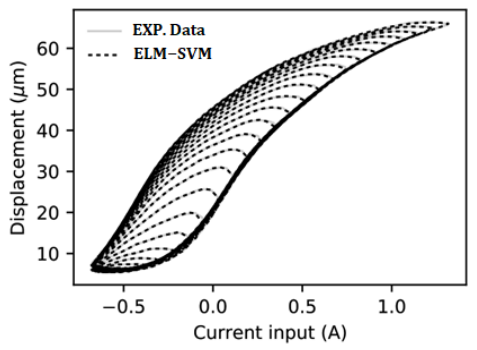
Figure 10. The measured output displacement against the input current of a magnetostrictive actuator and comparing the results of experimental [33] with the ELM − SVM method results.